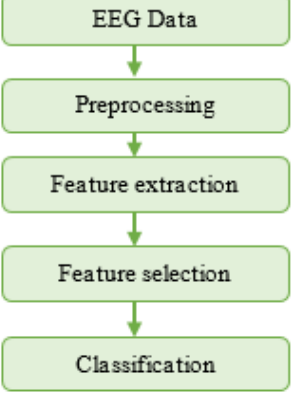
Figure 1. The flow chart for automatic epileptic seizure detection in artificial intelligence-based personalized medicine.